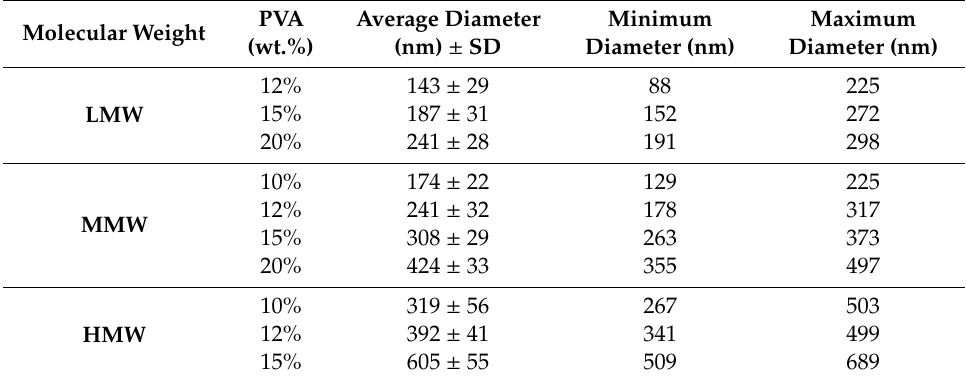
Table 3. Diameters of the obtained electrospun fibers from PVA / colloidal dispersions blends (60:40). Molecular